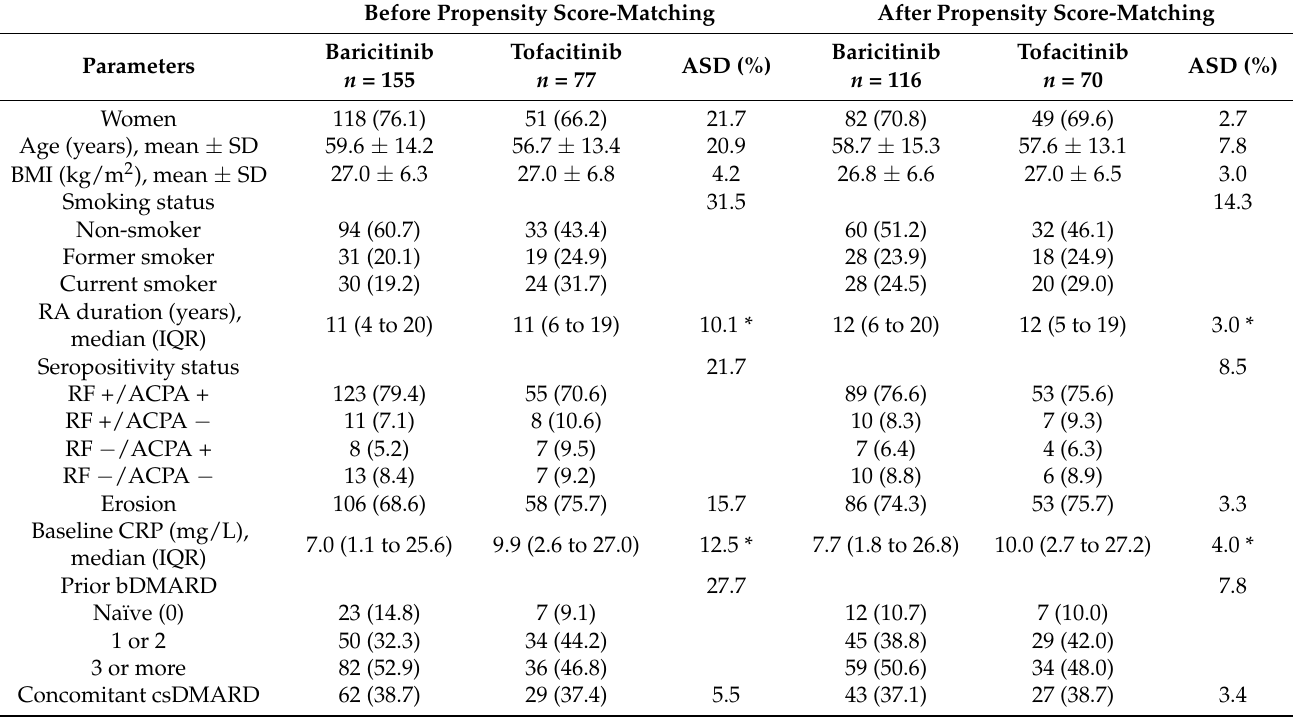
Table 1. Baseline characteristics according to molecules before and after propensity score-matching. Before Propensity Score-Matching After Propensity